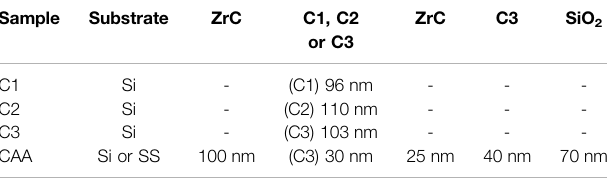
TABLE 2 | The deposition parameters of the coatings including composite ceramic layers (C1, C2, and C3) with different ZrC volume ratios in Al 2 O 3 , ZrC infrared (IR) layer, Al 2 O 3 , SiO 2 , and CAA a .